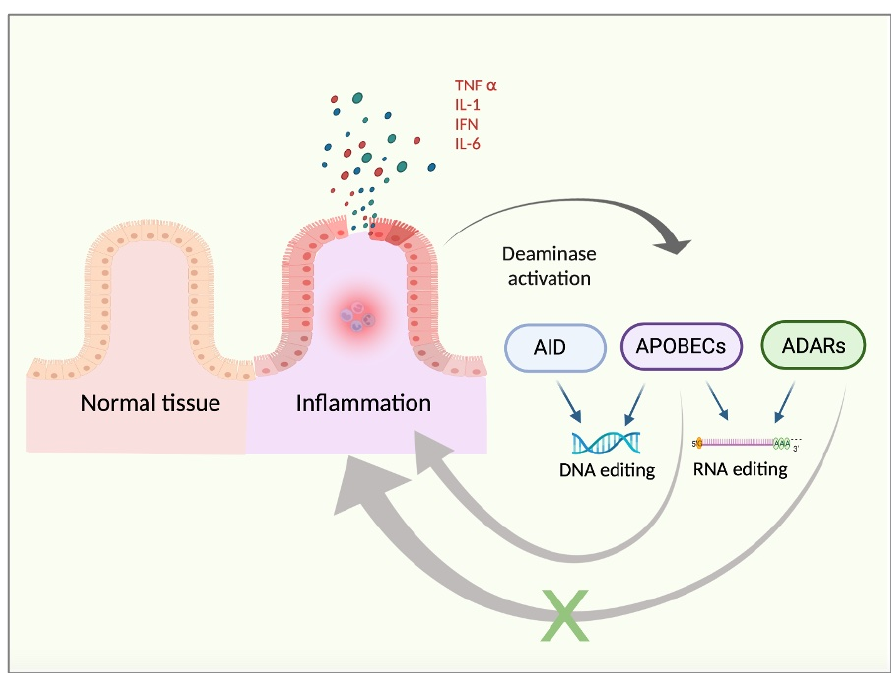
Figure 1. Chronic inflammation background. Inflamed tissue releases pro-inflammatory cytokines, such as TNF α , IFN, IL1, or IL6. These factors may trigger the activation of the pro-inflammatory pathways in the target cells, with NFK β signalling being a representative example. Such a pro-inflammatory response may lead to increased DNA- and RNA-based editing by enhanced activity of deaminases, such as AID, APOBECs, and ADARs. Moreover, deaminases exhibit opposite regulatory feedbacks in the context of inflammation. To note, APOBEC activity may sustain chronic inflammation in a positive feedback loop whereas ADAR activity may be prone to inducing an anti-inflammatory response, thus exerting negative control feedback.